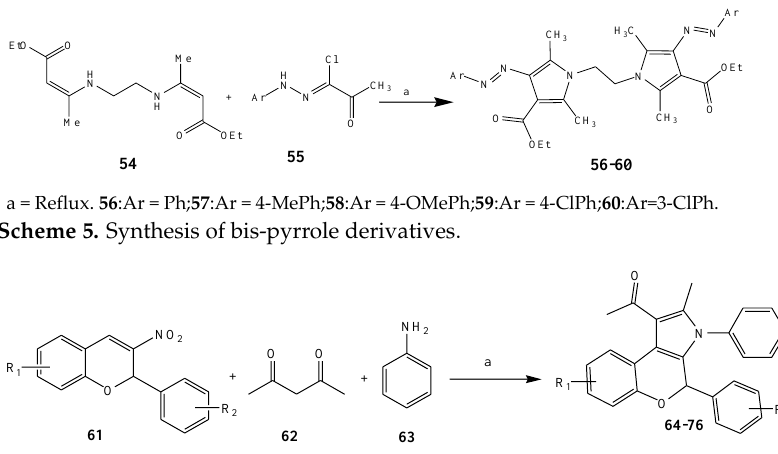
Scheme 4. Synthesis of pyrrole from 1,4-dicarbonyls